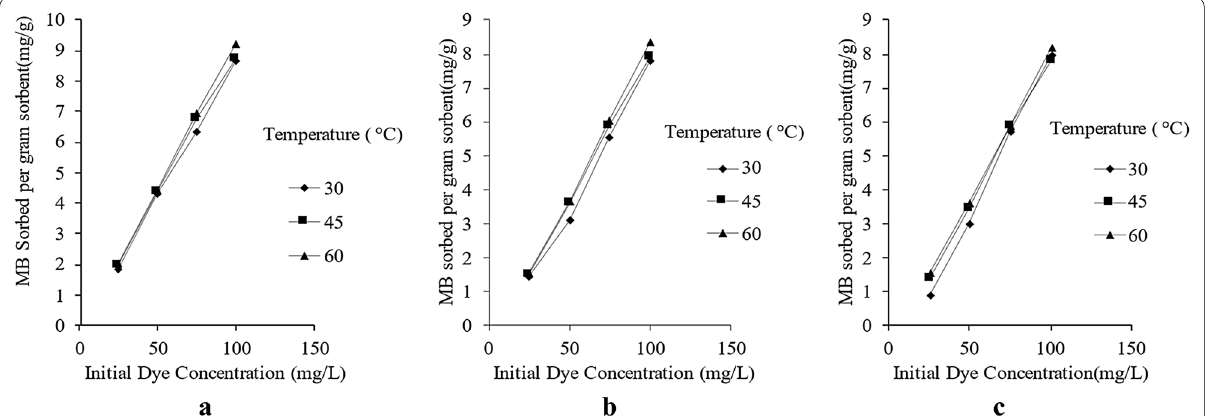
Fig. 4 a Impact of temperature on the MB removal for SD at 30 °C, 45 °C and 60 °C; b Impact of temperature on the MB removal for CS at 30 °C, 45 °C and 60 °C; c Impact of temperature on the MB removal for GNS at 30 °C, 45 °C and 60